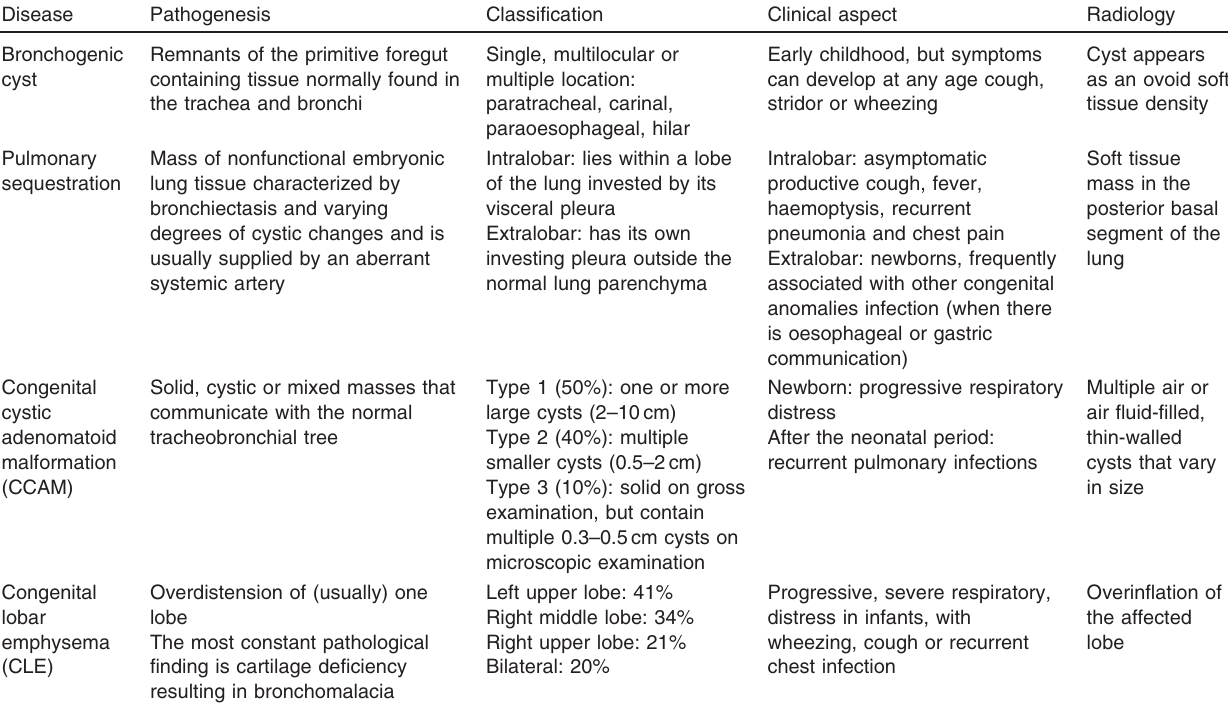
Table 2 Differential diagnosis of congenital cystic lung disease and parenchymal lung lesions presented as recurrent pneumonia